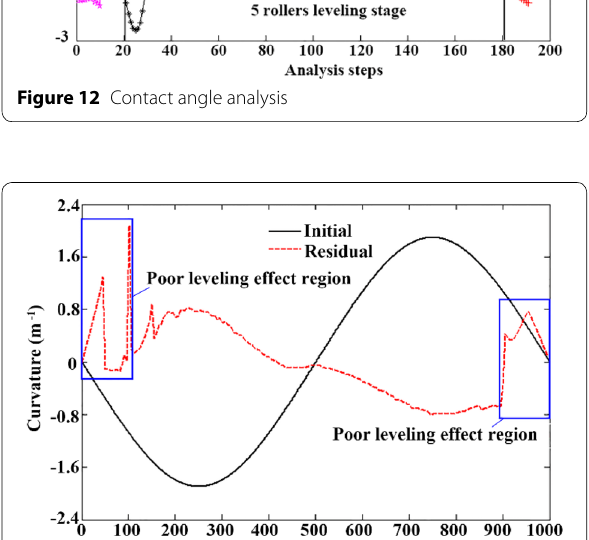
Figure 13 Curvature